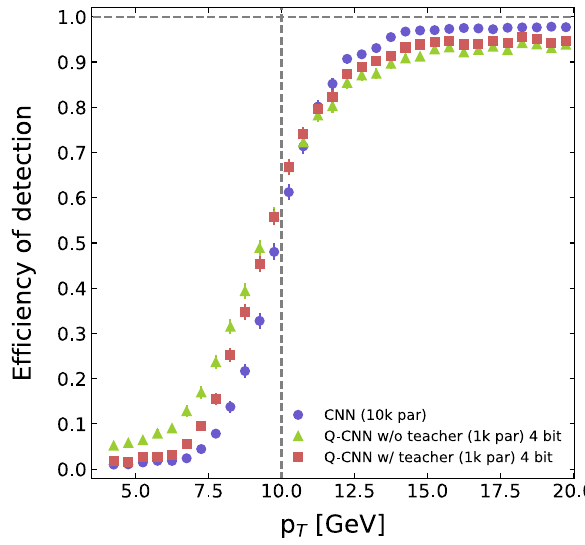
Fig. 7 Efficiency curves (realized as for Fig. 6). Statistical uncertain- ties computed as binomial confidence intervals are shown as well. If not visible, they’re smaller than the markers size. Here in indigo (circles) the performance of the Teacher model. In light green (triangles) the performance of the Student trained without any help from the Teacher. In red (squares) the performance of the Student trained with hints from the Teacher